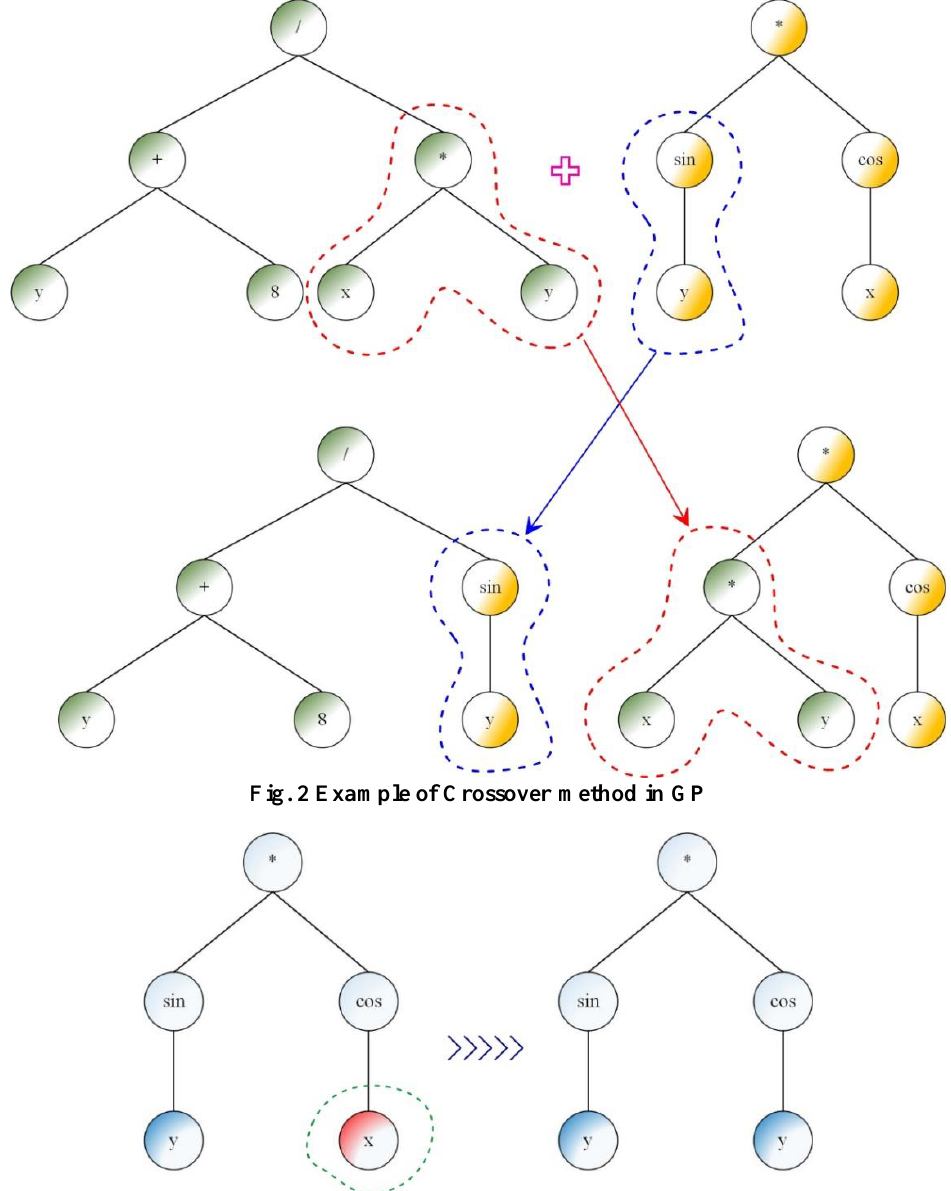
Fig. 3 Example of point